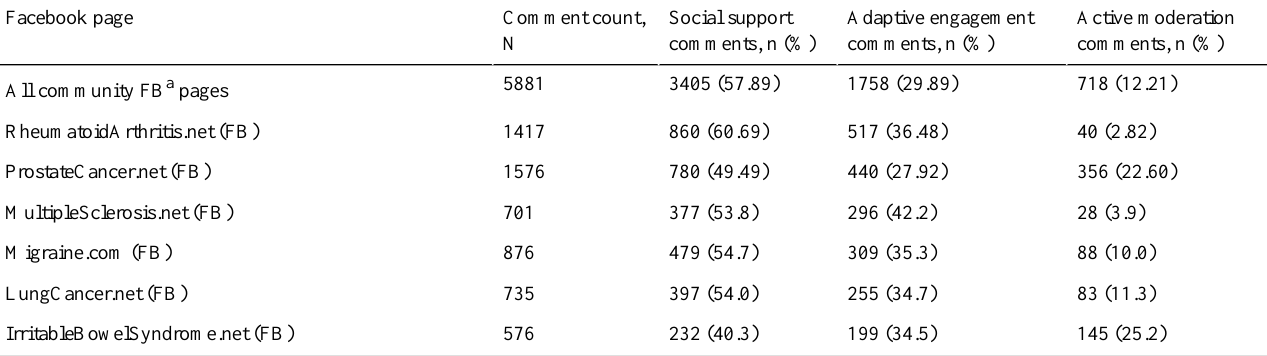
Table 4. Comment counts and frequency distribution of model elements by community Facebook